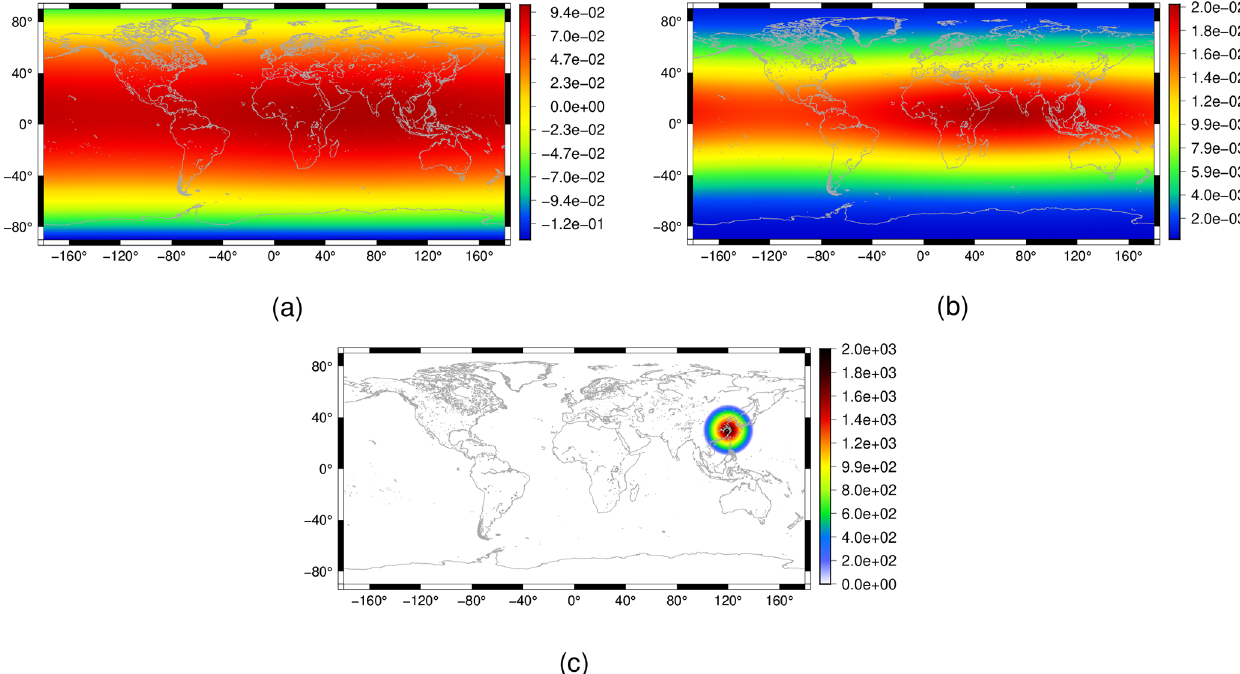
Figure 18. Flow over a mountain test case for the moist shallow-water model: initial conditions for the vapor (a) and temperature (b) fields, as well as the considered topography (c)